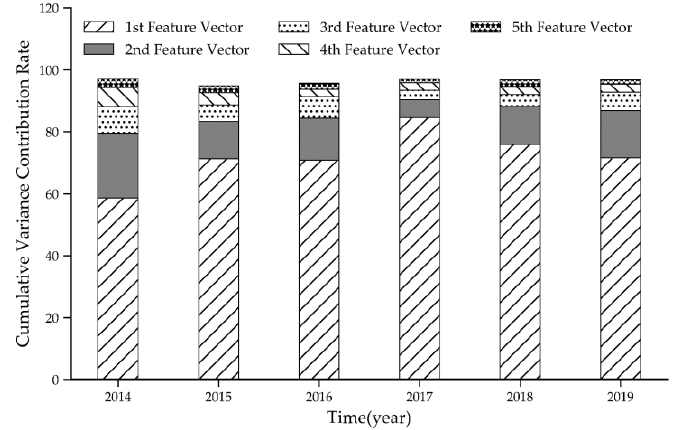
Figure 2. Variance contribution rate of each feature vector.